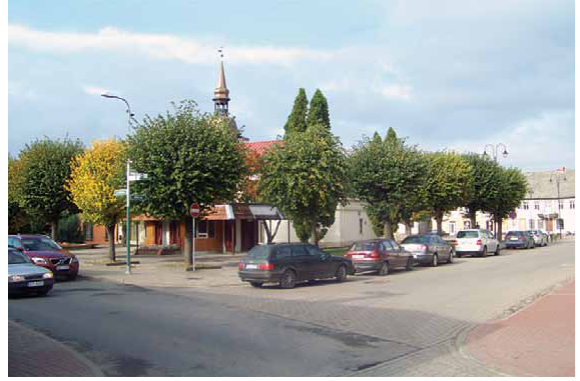
Fig. 2. The southern part of the Town Hall Square is hid by linden tree plantations. Source: author’s photo, 2012.